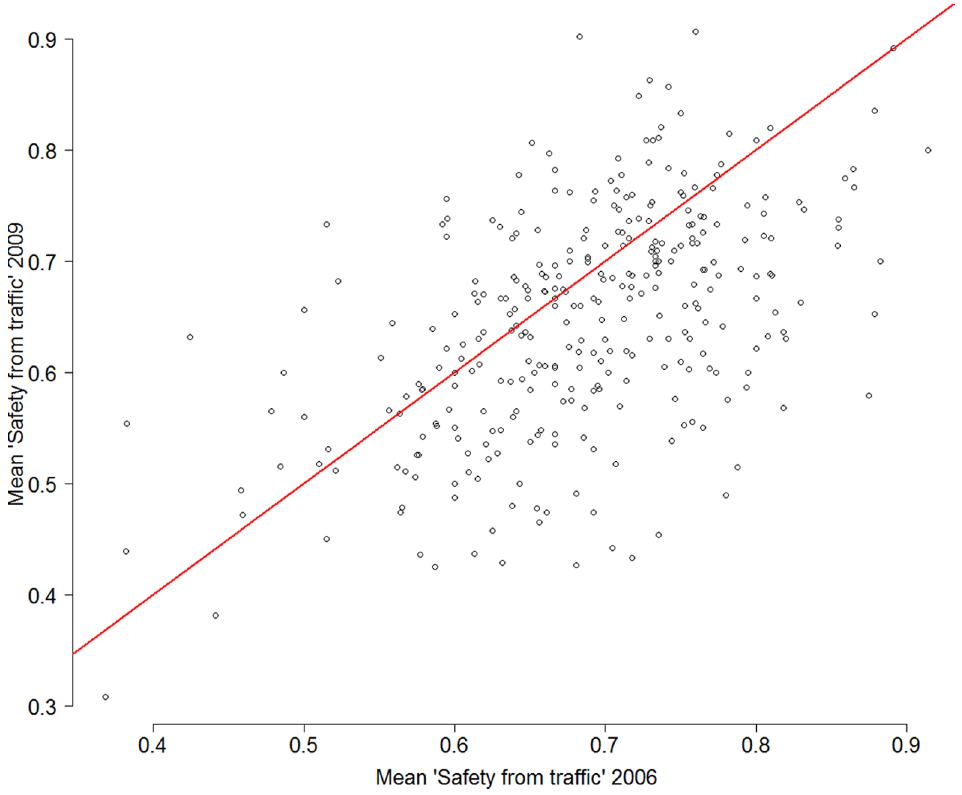
Figure 2. Traffic safety in neighborhoods: 2009 levels plotted against 2006 levels (both measured at neighborhood level). Correlation coefficient is